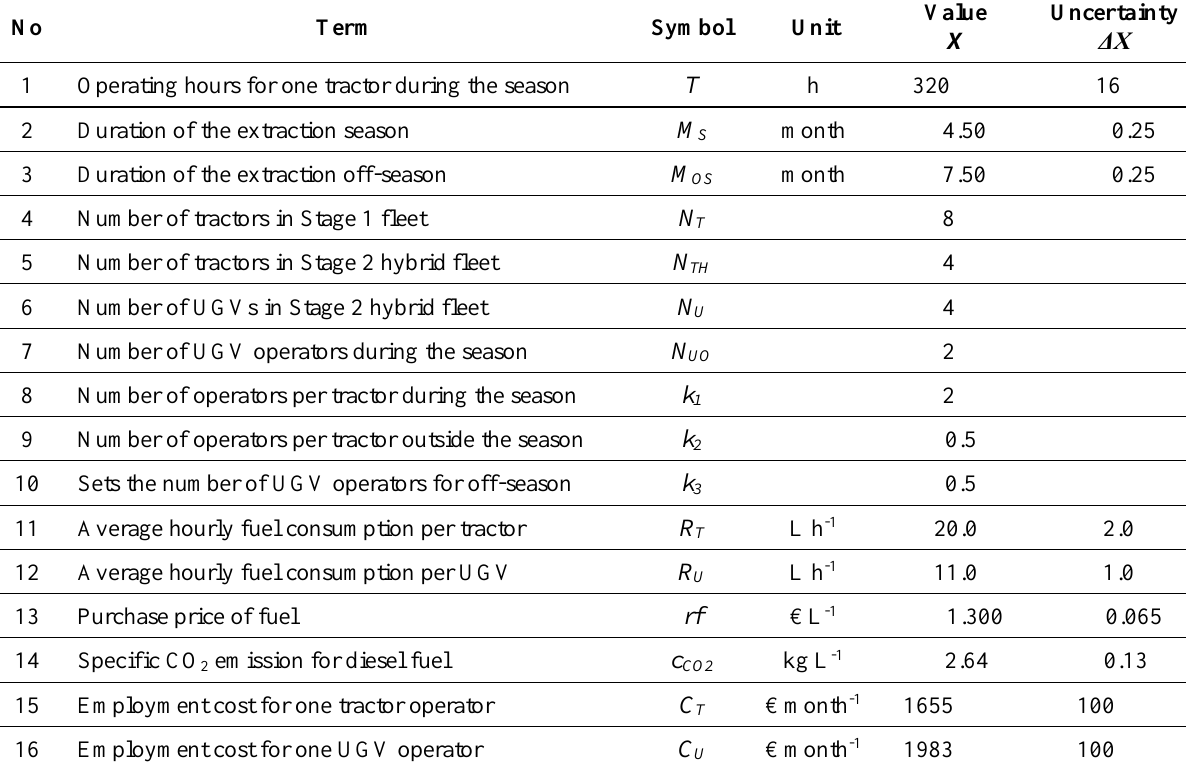
Table A1. Initial data for a sample problem in which Equations 1–11 are evaluated. In this task, the object of interest is a peat field with a surface area of 140 hectares and the ‘vacuum harvester’ collection method is used. The calculations reflect the purchase price of fuel and average salaries in Estonia as of 01 Mar